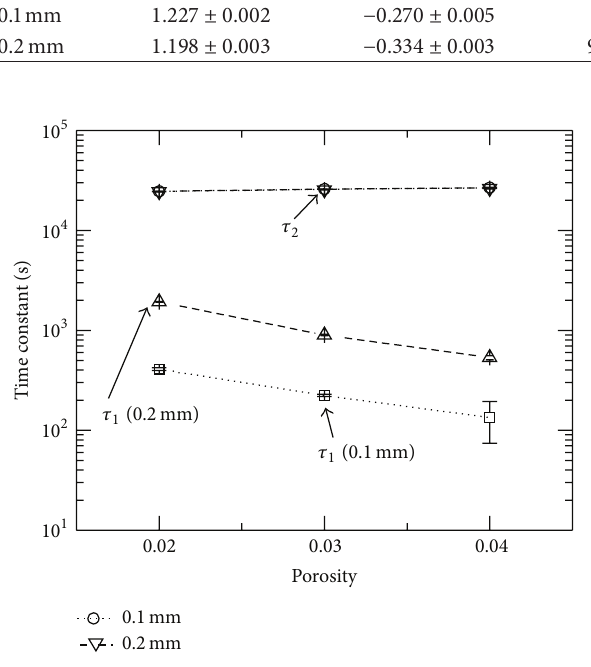
Figure 9: Time constants 𝜏 1 and 𝜏 2 as functions of porosity with the coating thickness as a parameter. The bulk conditions were 0.01M NaCl, pH 9, 10 −15 M Al 3+ , and the applied dc potential was − 1.9V.